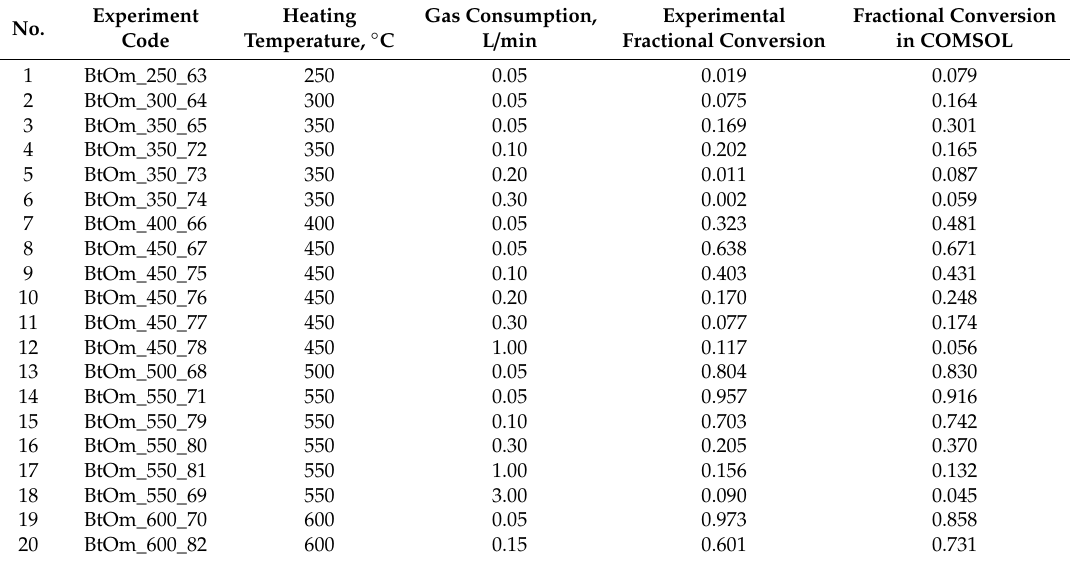
Table 10. Comparison of the experimental fractional conversion of O-methyl-N-butyl carbamate with the data of the calculation